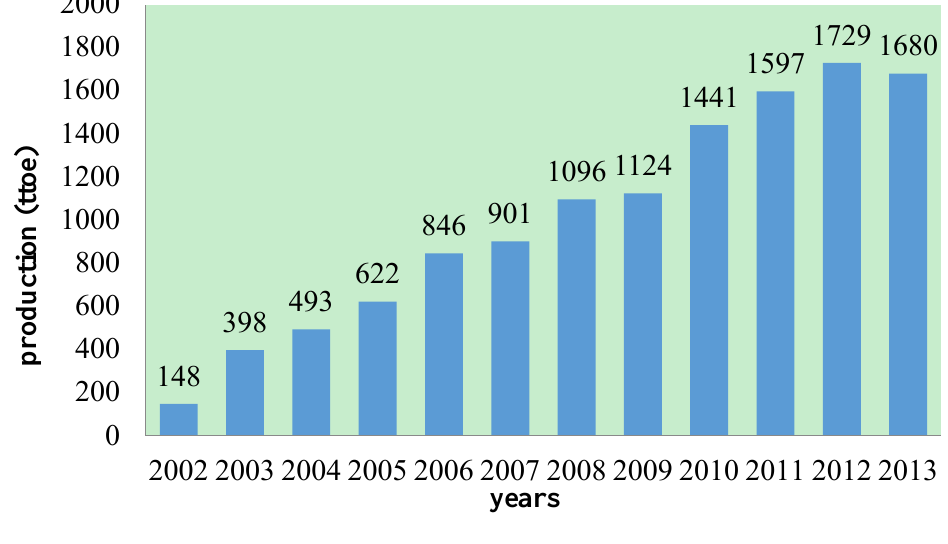
Figure 2. China’s biofuel production from 2002 to 2013.